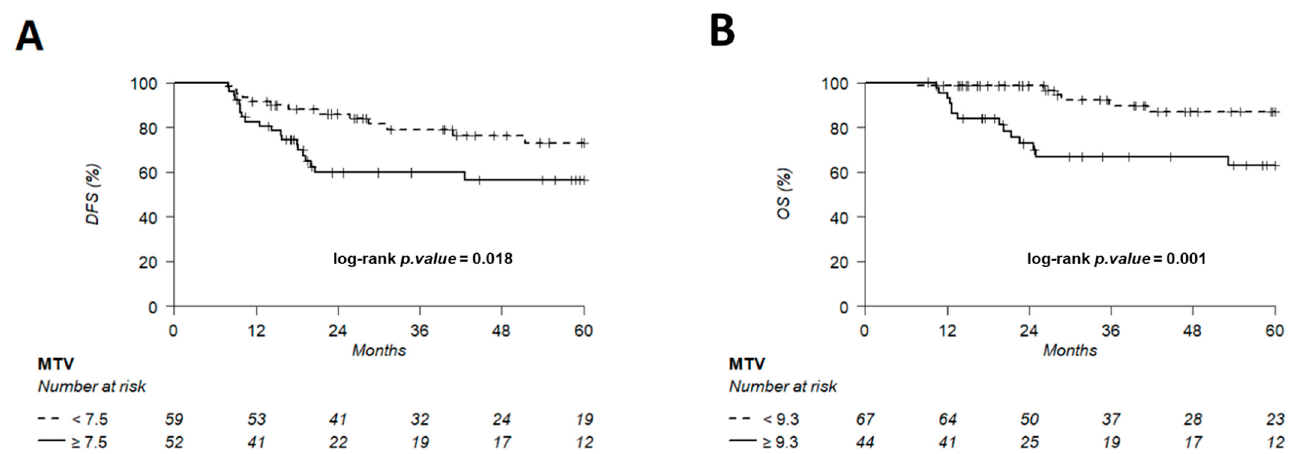
Figure 8. Kaplan–Meier of DFS ( A ) using an MTV threshold of 7.5 and OS ( B ) using an MTV threshold of 9.3. Thresholds are predetermined using Young’s index.